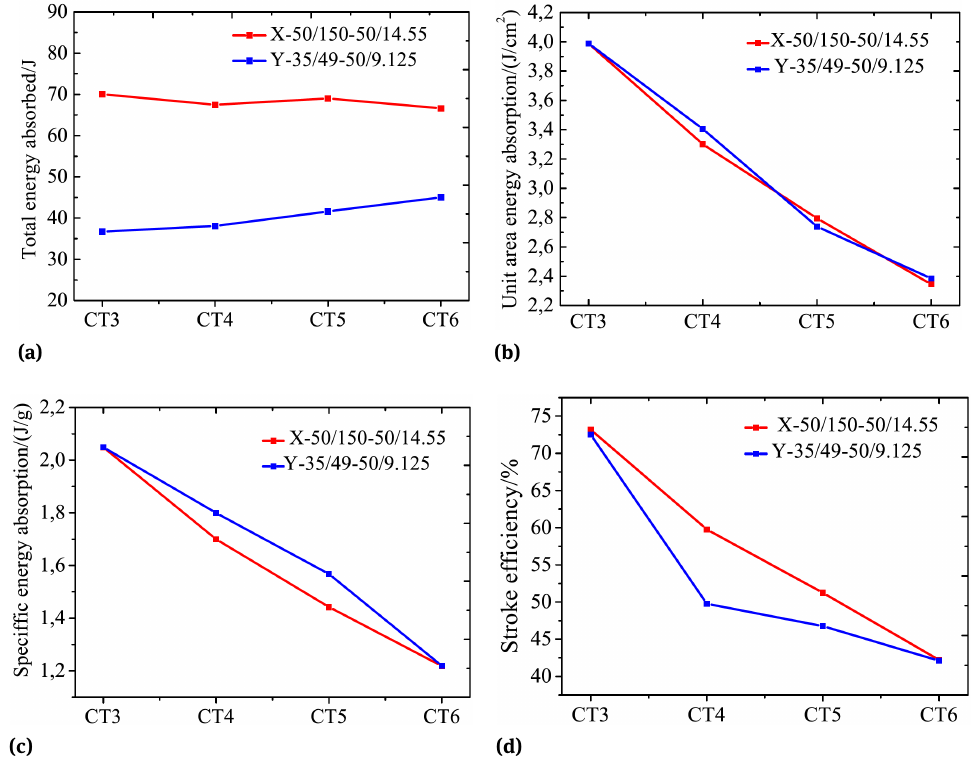
Figure 7: Cushioning energy absorption for different cross-sections: (a) total energy absorbed, (b) unit area energy absorption, (c) specific energy absorption and (d) stroke